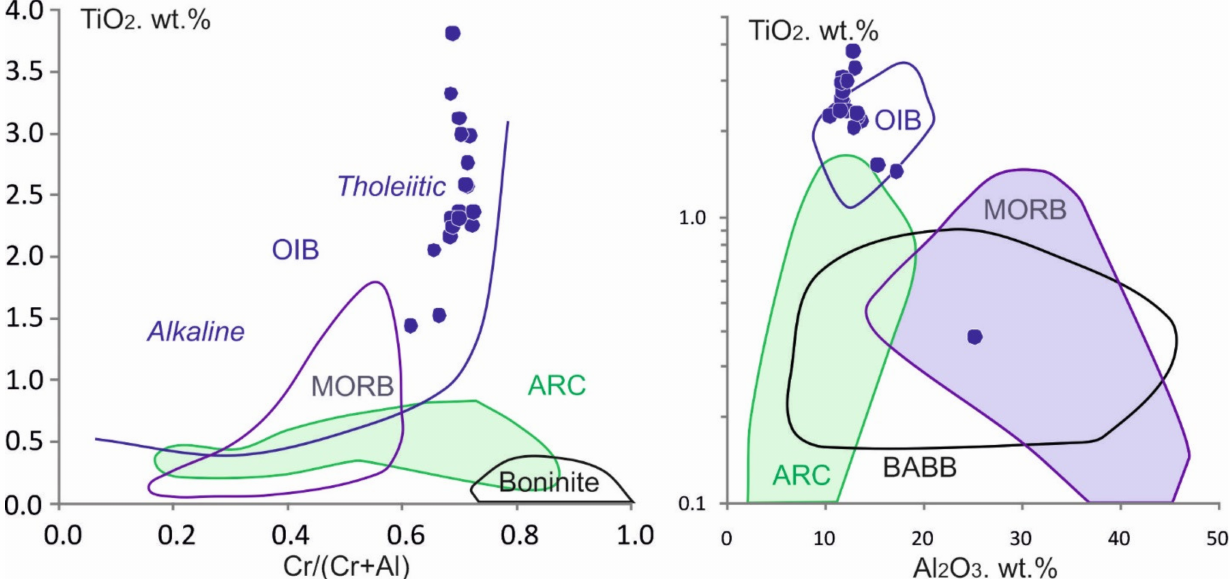
Figure 7. TiO 2 vs. Cr/(Cr + Al) and Al 2 O 3 diagrams by [34,35], respectively, for Cr-spinel from the meimechite-picrite complex of Sikhote-Alin (simplified from [23]). MORB, Mid-Ocean Ridge Basalt; OIB, Oceanic Island Basalt; ARC, Arc (subduction-related) basalts; BABB, Back-Arc Basin